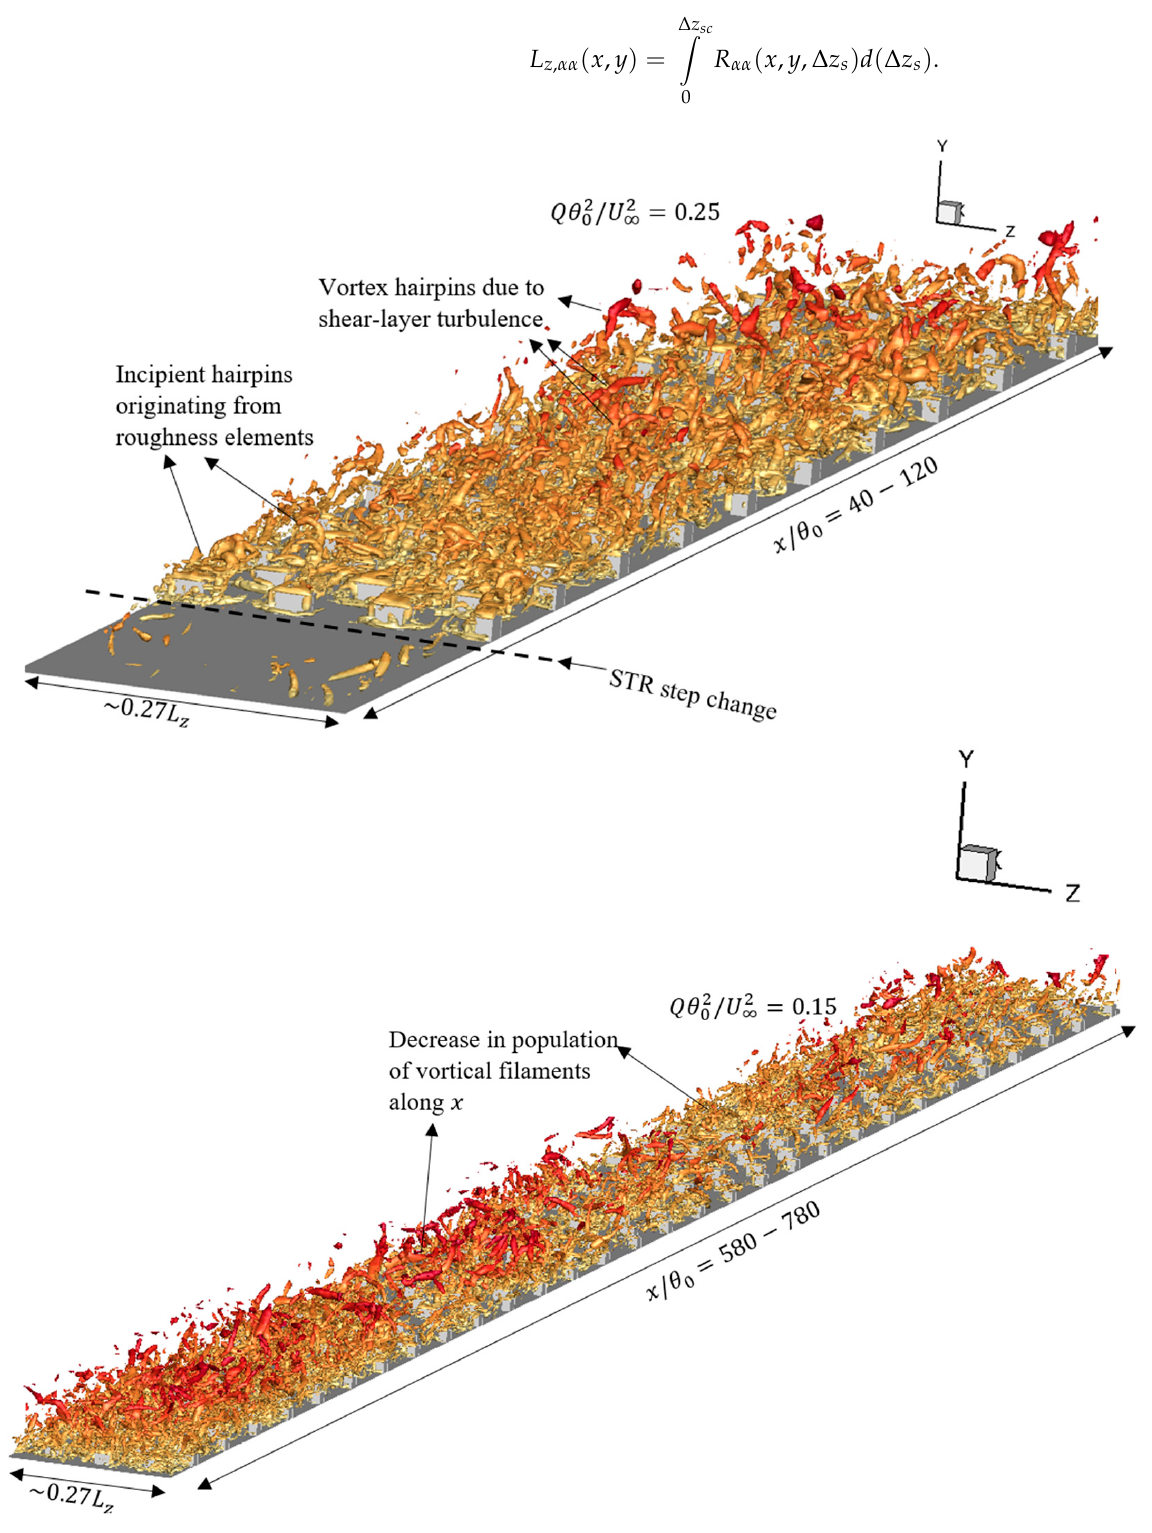
Figure 18. Visualization of iso-surfaces of the Q –criterion at Q θ 2 ( bottom panel ). The iso-surfaces are colored by the wall normal distance: y / θ 0 = 0 (yellow); y / θ 0 = 4 (red). ( Top panel ): 40 ≤ x / θ 0 ≤ 120; ( bottom panel ): 580 ≤ x / θ 0 ≤ 780. Only about 1/3rd of the entire spanwise domain is